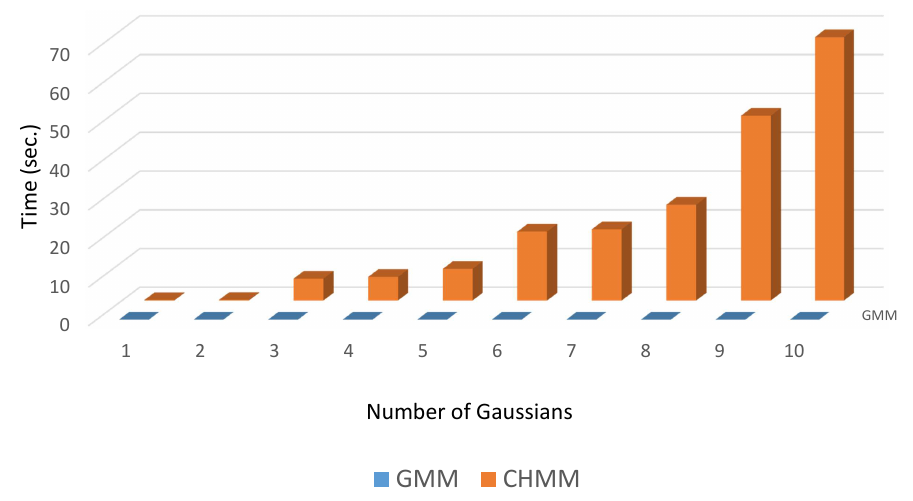
Figure 13. Training time using GMM and CHMM for different number of